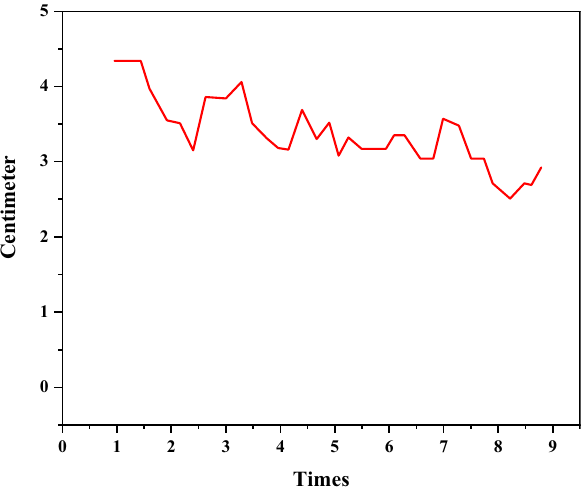
Figure 3: Data diagram of the dynamic de fl ection change in the right side of the Gaojia Garden